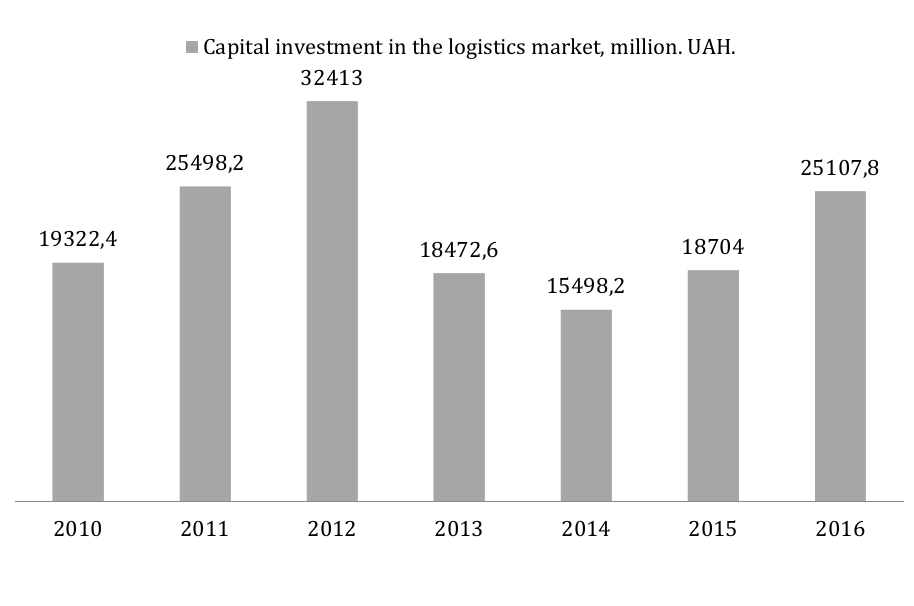
Figure 4: Dynamics of capital investment in the logistics